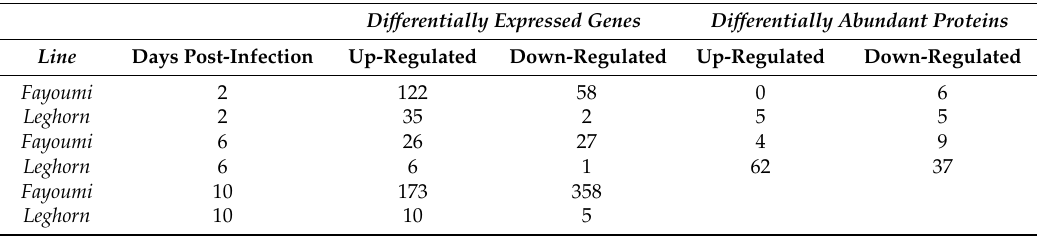
Table 1. Number of differentially expressed genes (DEGs) and differentially abundant proteins (DAPs) in Fayoumis and Leghorns at each timepoint with a false discovery rate (FDR) < 0.05. Differentially Expressed Genes Differentially Abundant